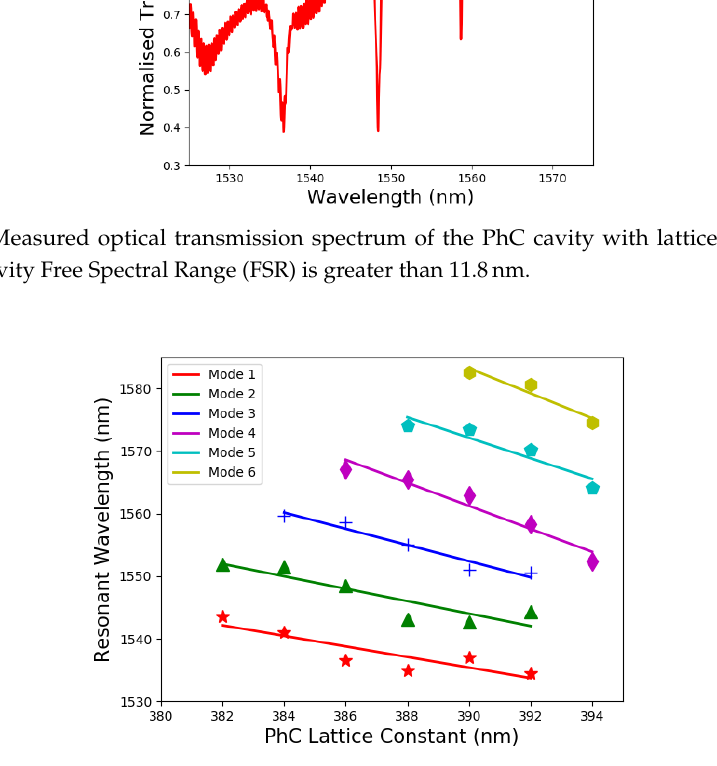
Figure 5. Measured resonant wavelengths of the PhC cavity and their variation with PhC lattice constant spacing. For each of the modes it is observed that ∆ λ / ∆ a = − 1.4 ±